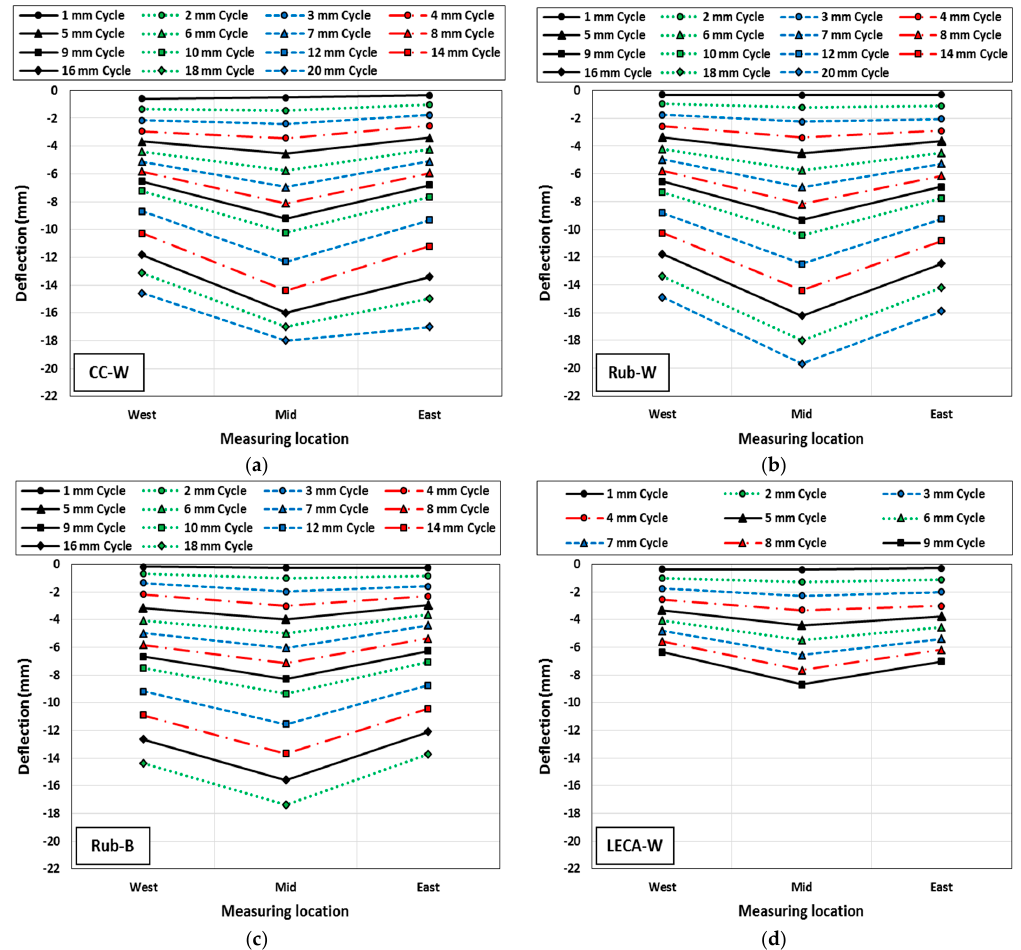
Figure 15. Deflection patterns at each loading cycle for ( a ) CC-W, ( b ) Rub-W, (c) Rub-B, and (d) LECA-W.